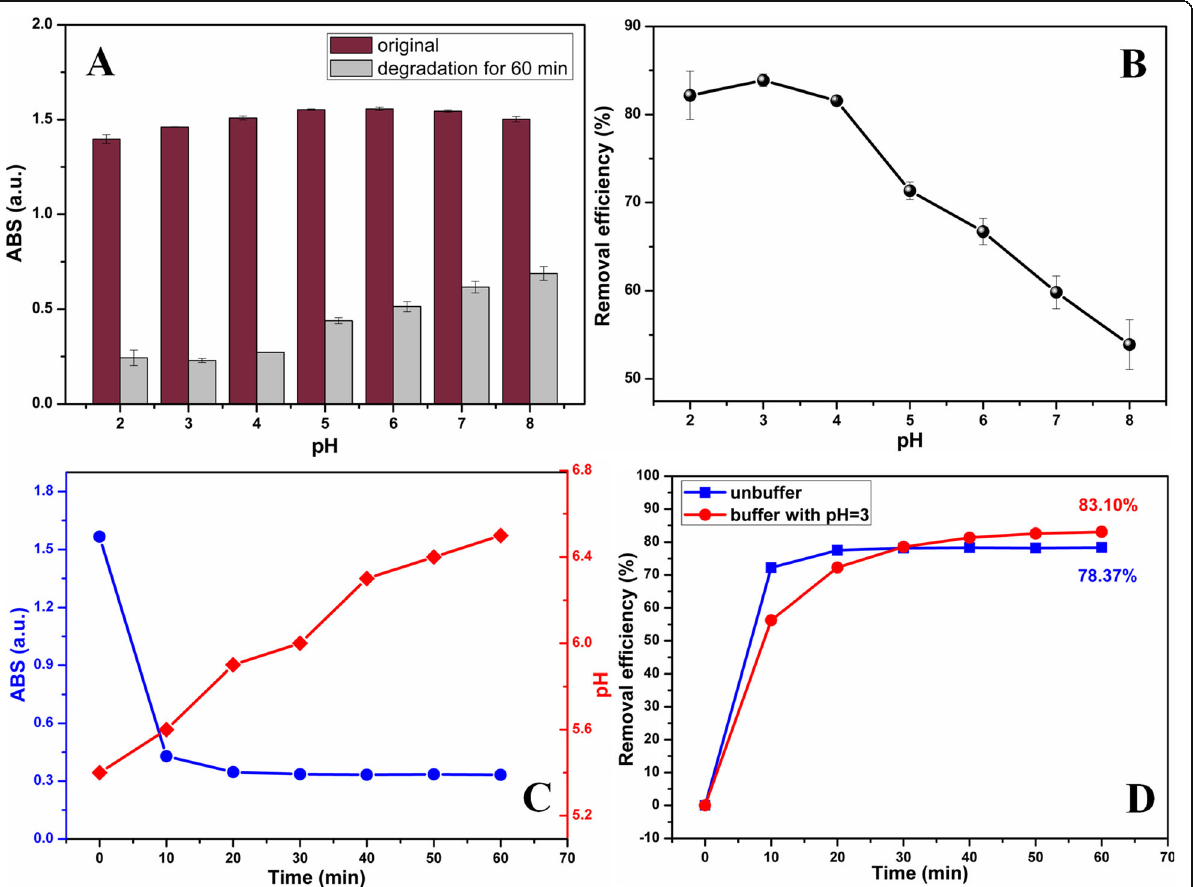
Fig. 5 a The absorption intensity of TCH before and after degradation and ( b ) removal efficiency under different pH. c The time-dependent absorption intensity of TCH and pH variation under unbuffered condition. d Comparison of removal efficiency of TCH under buffered and unbuffered conditions. (Conditions: 20 slices of MnO 2 NPs/ESM, the initial concentration of TCH was 50